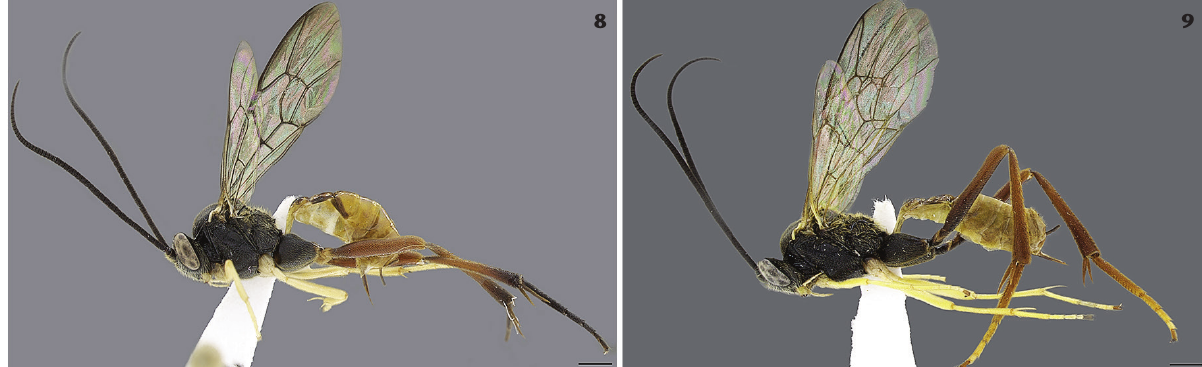
Figures 8-9. Habitus of females of Cryptophion species in lateral view: (8) C . guillermoi ; (9) C . espizonai . Scale bar: 0.8